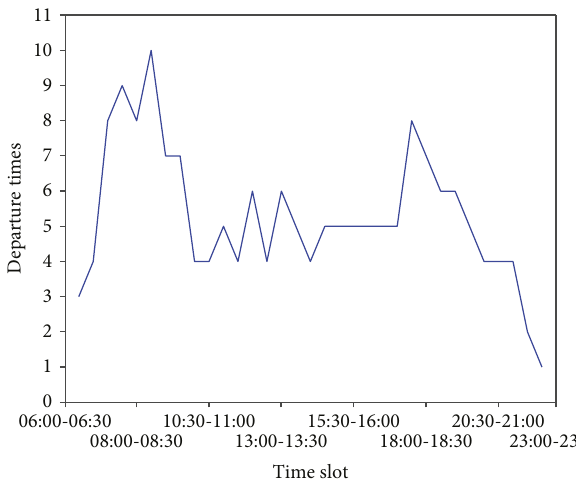
Figure 11: Departure curve for bus line